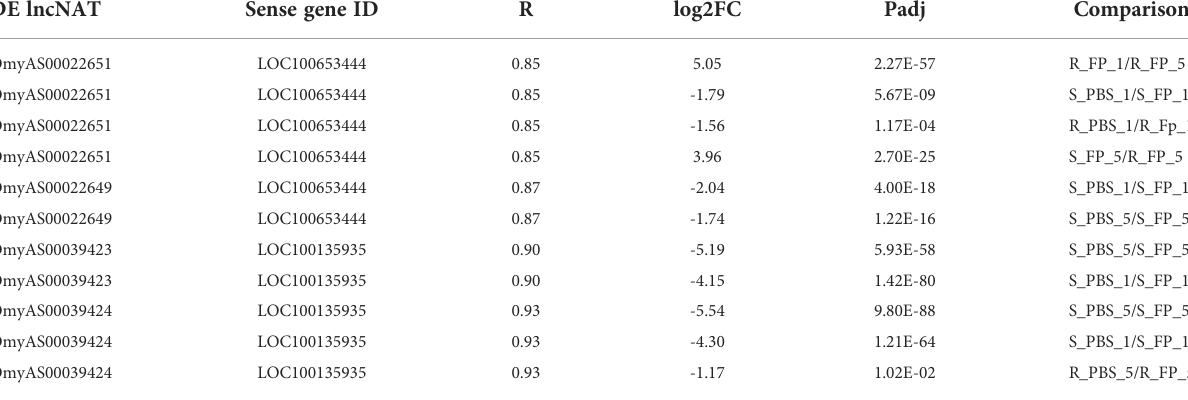
TABLE 2 Correlation between expression patterns of four DE lncNATs and their overlapping hepcidin genes across 24 RNA-Seq datasets. DE lncNAT Sense gene ID